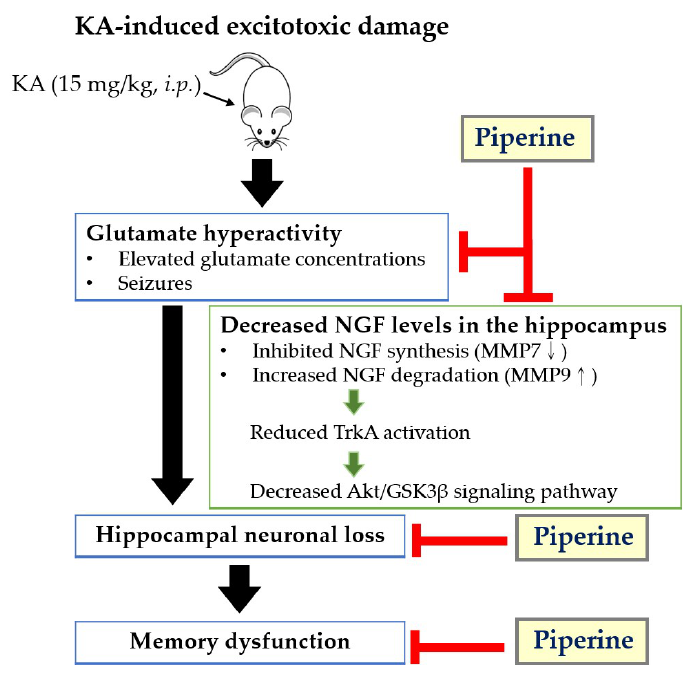
Figure 8. Schematic diagram representing the neuroprotective effects of piperine in the hippocampus of rats induced by KA. Piperine pretreatment ameliorates glutamate hyperactivity, upregulates NGF expression by increasing MMP7 levels and decreasing MMP9 levels, and enhances TrkA and Akt/GSK3β activation, which prevents KA-induced neuronal loss and maintains memory function. Arrows indicate KA-induced regulation, and T-bars indicate piperine-mediated inhibitory effects.